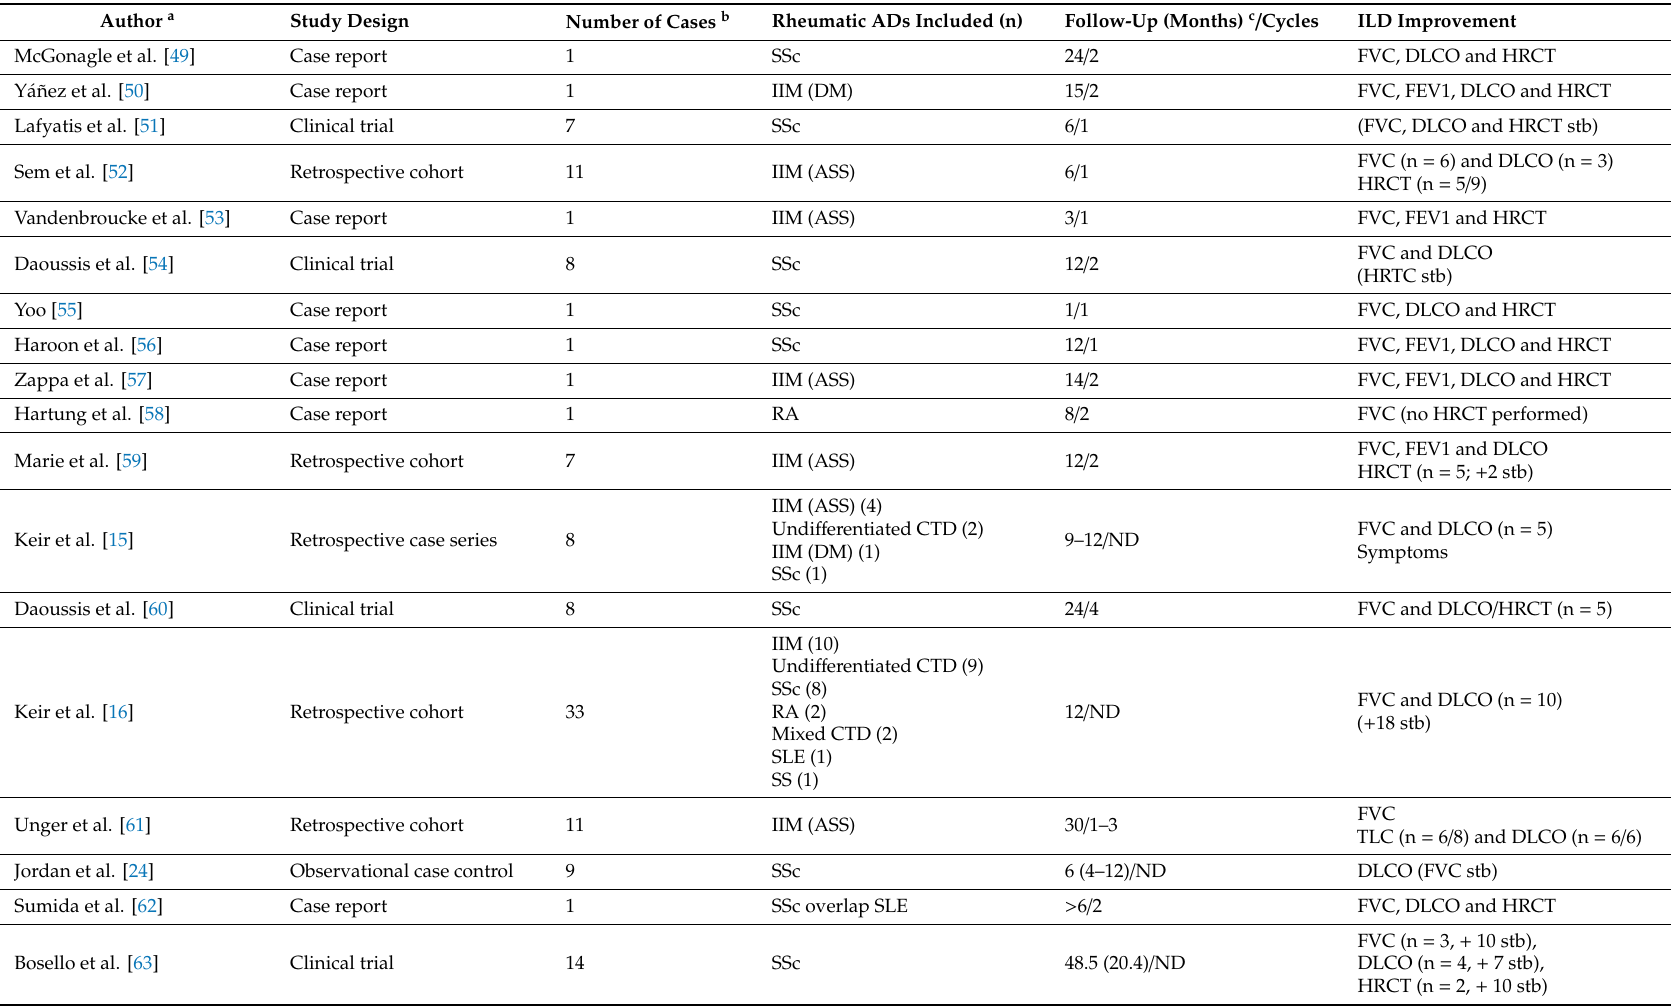
Table 3. Literature review of patients with AD-ILD treated with